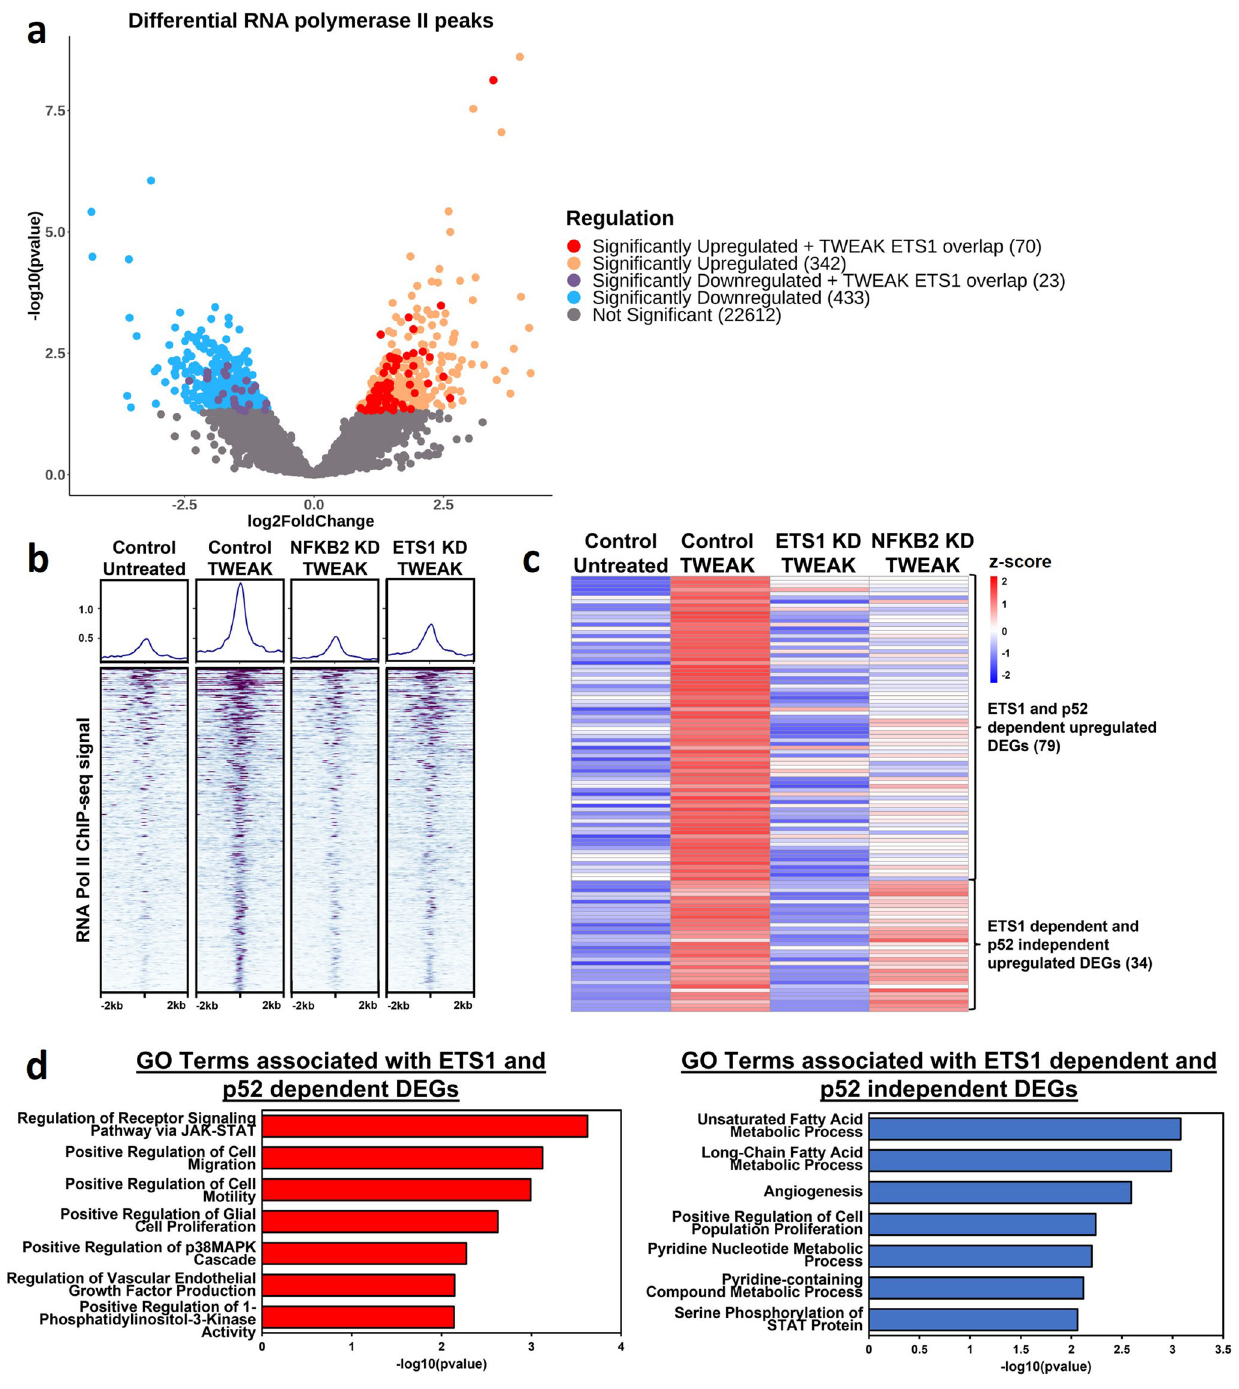
Fig. 2 p52-driven ETS1 alters RNA polymerase II recruitment and the transcriptomic landscape of glioma cells. a Volcano plot depicting differential RNA polymerase II binding following NF- κ B/p52 activation and those bound by ETS1. b DNA binding heatmap of the signi fi cantly upregulated RNA polymerase II sites following NF- κ B/p52 activation and the effect of NFKB2 and ETS1 KD. c Heatmap depicting ETS1-dependent, signi fi cantly upregulated genes following NF- κ B/p52 activation. d Bar chart depicting enriched GO terms from signi fi cantly upregulated ETS1 and p52-dependent differentially expressed genes (DEGs) as well as ETS1-dependent and p52-independent